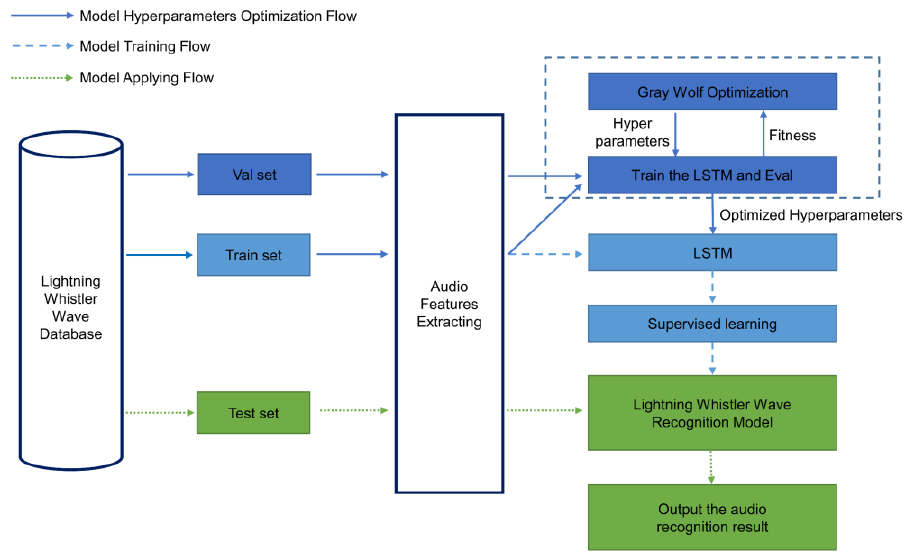
Figure 1. Architecture as well as the methodological steps of the lightning whistler wave recognition scheme. Overall, the flow chart comprises three procedures: model hyperparameter optimization flow, model training flow, and model application flow. The input of the model is the feature map matrix extracted from wave audio, and the output (i.e., likelihood value from 0 to 1) denotes whether the wave is lightning whistler wave or not.